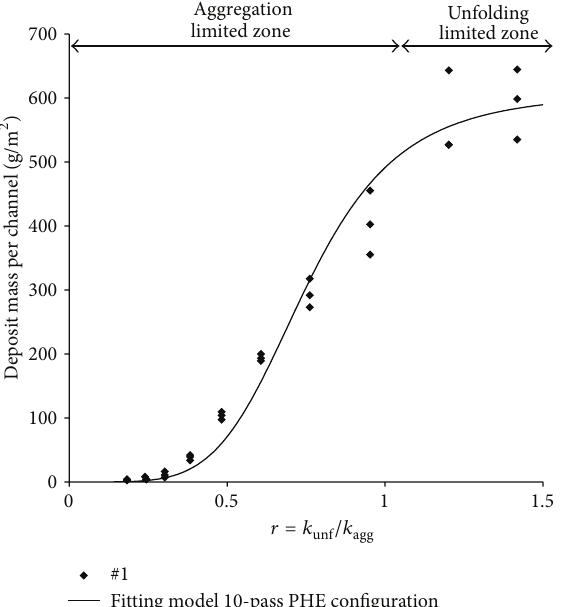
Figure 11: Variation of the dry deposit mass per unit area in the various channels with the ratio 𝑟 for a 10-pass PHE configuration (#1 corresponds to the thermal profile given in Figure 4 and Table